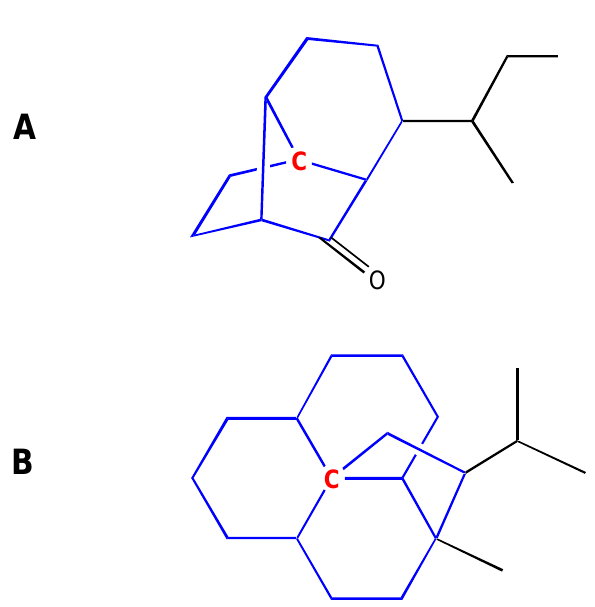
Figure 6. Choosing a ring class for an ambiguous center atom. A: the center atom is in bridged ring and fused ring systems; it is assigned to bridged ring system. B: the center atom is in fused ring, bridged ring and spiro ring systems; it is assigned to spiro ring system.